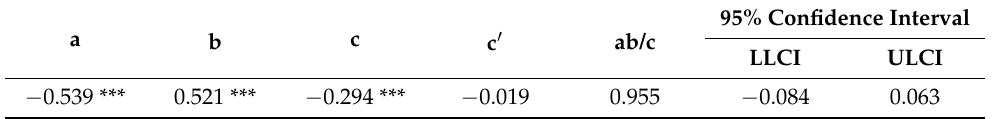
Table 7. Fitting index of the regression